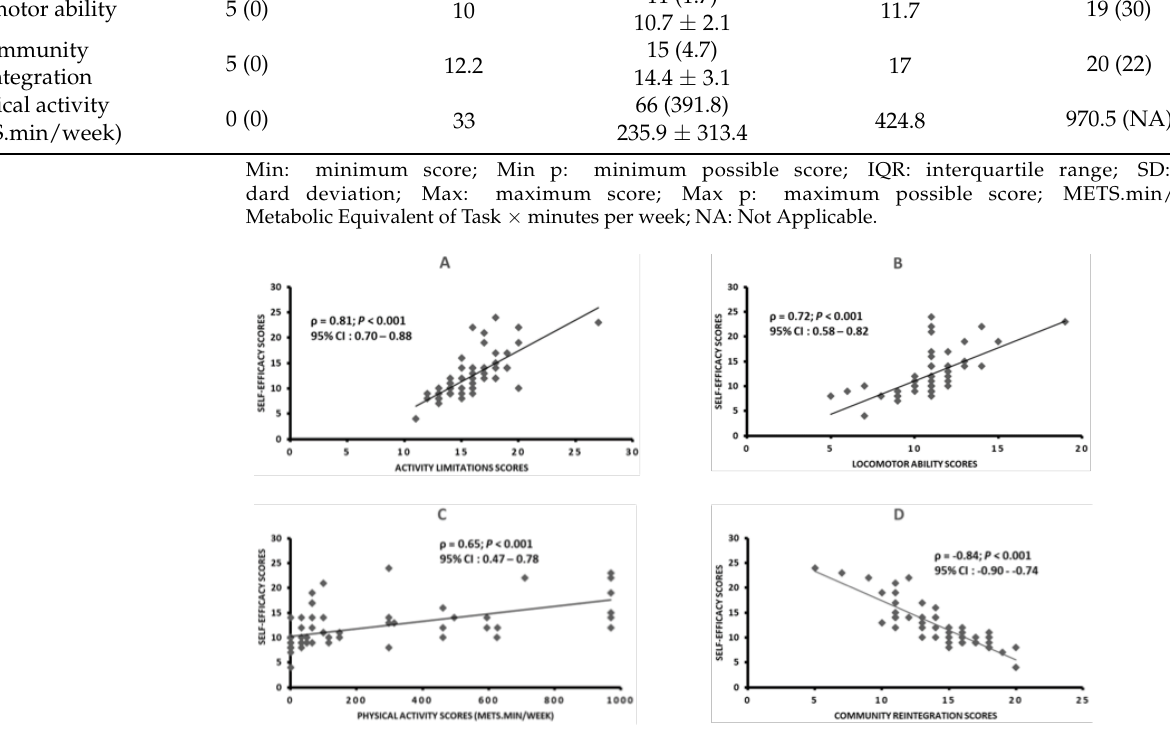
Figure 1. Spearman’s correlations between self-efficacy scores and activity limitations, locomotor ability, physical activity, and community reintegration scores; ρ: Spearman correlation coefficient; CI: confidence interval. Panel ( A ): Spearman’s correlation between self-efficacy scores and activity limitations scores; Panel ( B ): Spearman’s correlation between self-efficacy scores and locomotor ability scores; Panel ( C ): Spearman’s correlation between self-efficacy scores and physical activity scores; Panel ( D ): Spearman’s correlation between self-efficacy scores and community reintegration